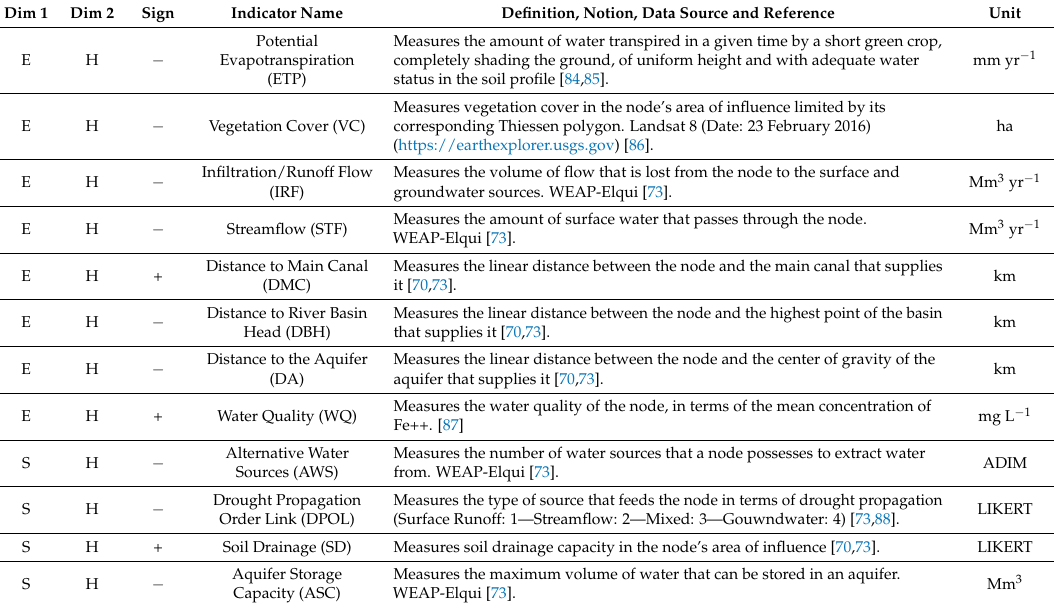
Table 3. Definitions and characteristics of water security indicators and data